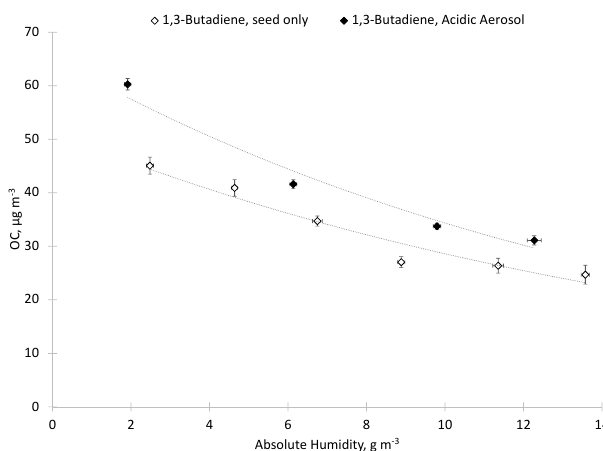
Figure 5. A comparison of the effects of humidity variation on isoprene/NO SOC formation. In ER666 (open diamonds), only a low-concentration ammonium sulfate seed aerosol was present. In ER444 (closed diamonds), an acidic sulfate aerosol was generated via